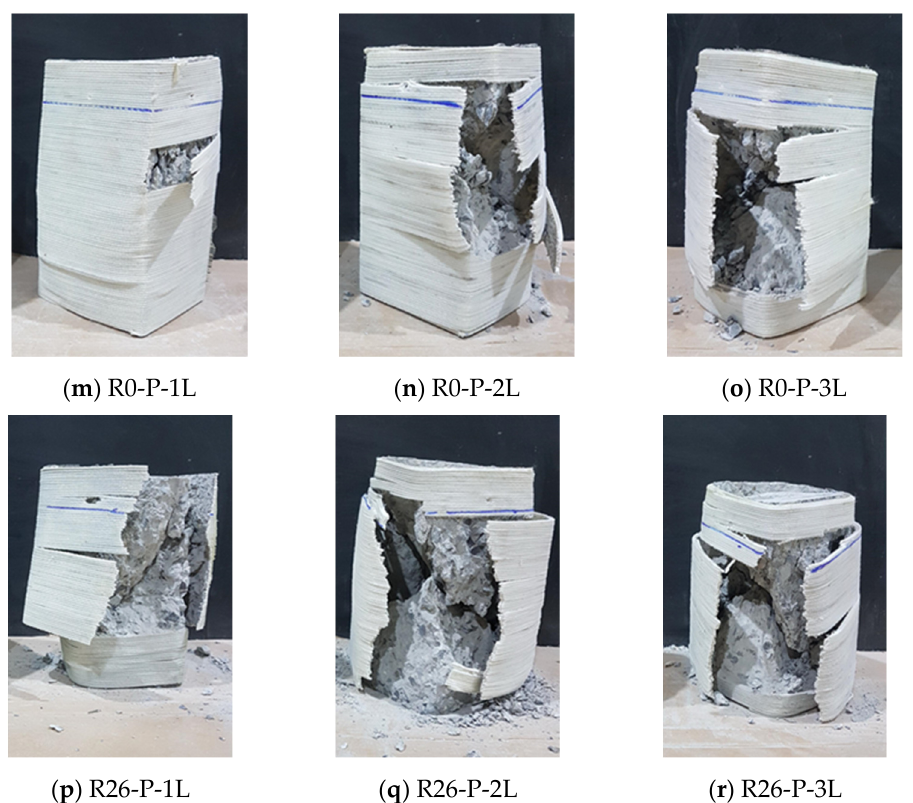
Figure 6. Ultimate failures of FRRP-confined specimens.